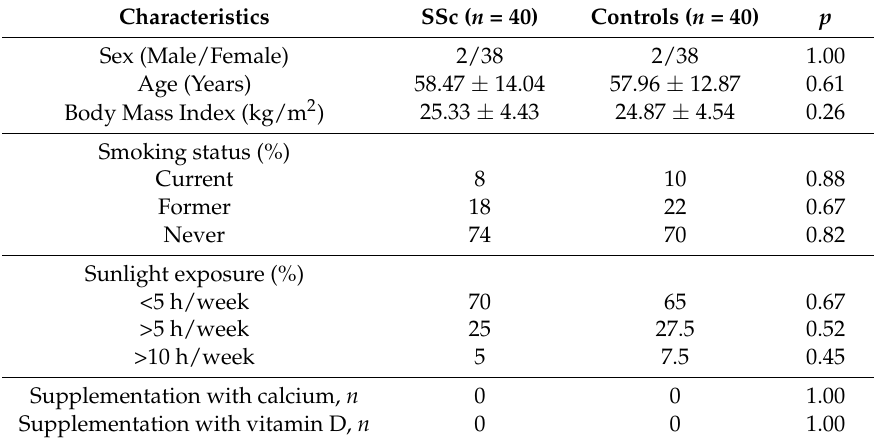
Table 1. Demographic characteristics of patients in the two groups; results are expressed as means ± SD and